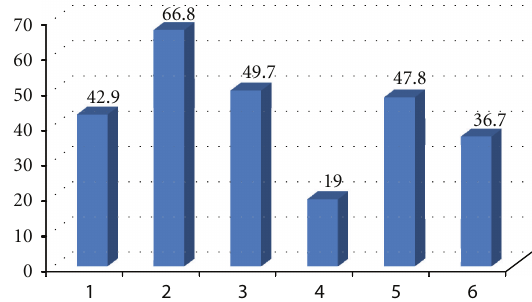
Figure 1: The prevalence (%) of each ICDAS code ( > 0) per child.